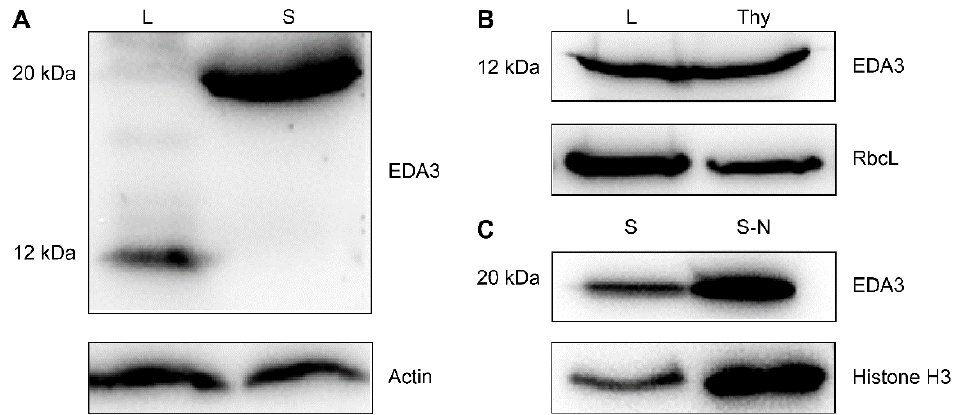
Figure 3. Immunoblot showing the dual localization of EDA3. ( A ) EDA3 localizes in leaves and seeds in the 12 and 20 kDa forms, corresponding to the truncated and full-length peptides, respectively. Actin was probed as a loading control; ( B ) EDA3 is a thylakoid protein in leaf cells. Rubisco large subunit (RbcL) was probed as a loading control; ( C ) EDA3 localizes in the nucleus in seeds. Histone H3 was probed as a loading control. L, leaves; S, seeds; Thy, thylakoid preparation; S-N, seed nuclear preparation.